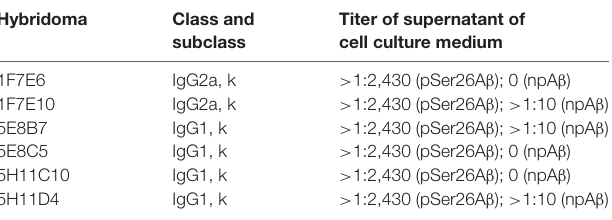
TABLE 1 | Ig classes and subclasses, and titer of monoclonal antibodies against pSer26A β